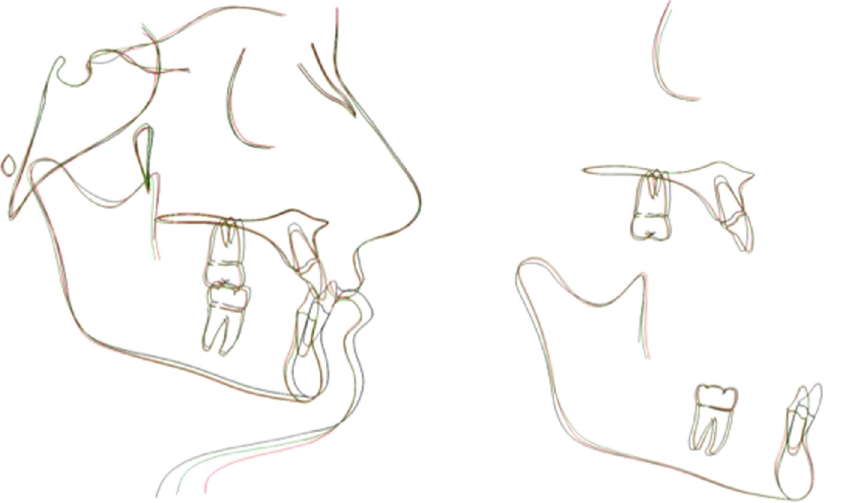
Figure 8. Superimposition of the lateral cephalograms taken at the beginning of treatment (black lines), end of treatment (red lines), and 2-year follow-up (green lines).